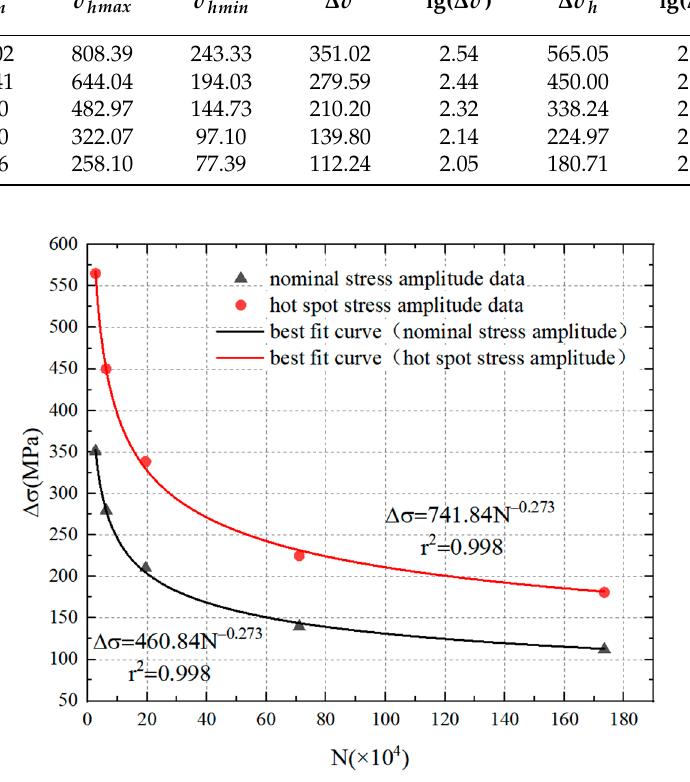
Figure 9. Power regression curves.